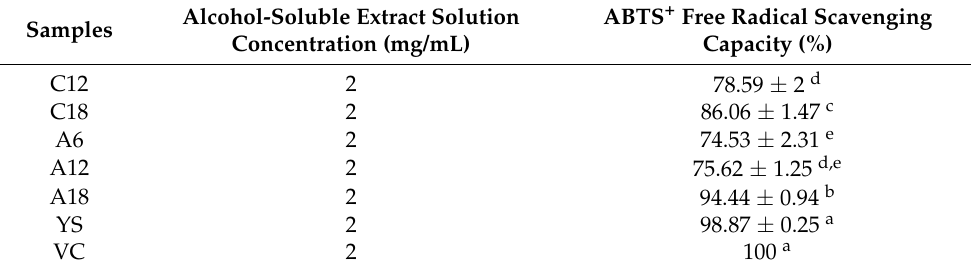
Each value represents the mean ± SD ( n =3); SD, standard deviation. At p < 0.05 according to one-way analysis of variation, mean values followed by different letters are significantly different from each other; mean values followed by one letter identical are not significantly different from each